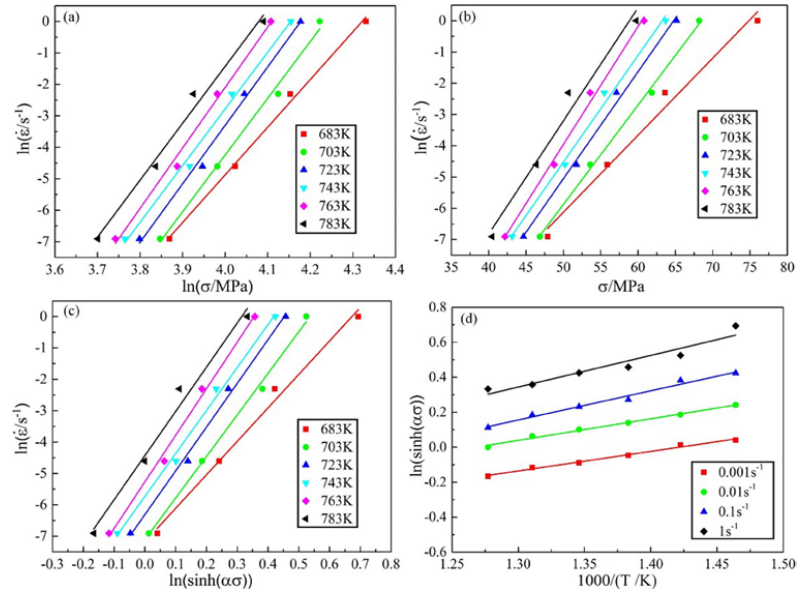
Figure 4. Relationship among stress, strain rate and temperature at a strain of 0.1: ( a ) ln ε  − ln σ ; ( b ) . ε − σ . ε − ( b ) ln ; ( c ) ln ln [ sinh ( ασ )] and ( d ) ln [ sinh ( ασ )] − 1000/ T